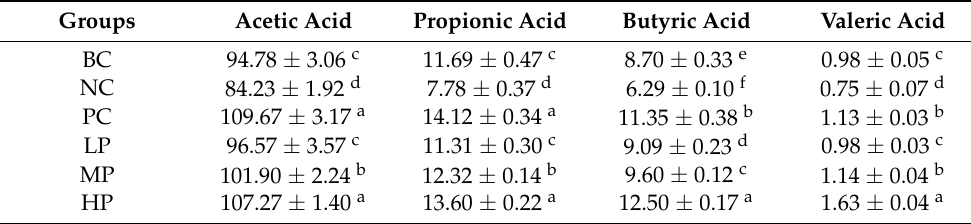
Table 1. Effect of BSP on SCFAs of mice feces ( µ